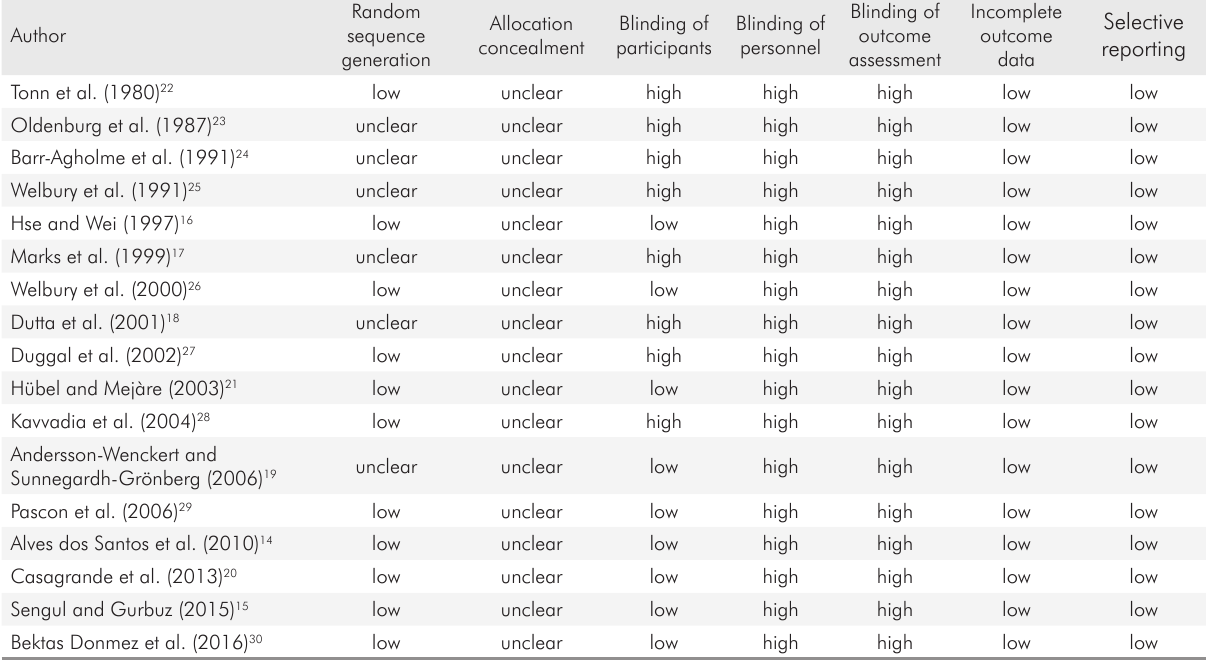
Table 2. Risk of bias of the included